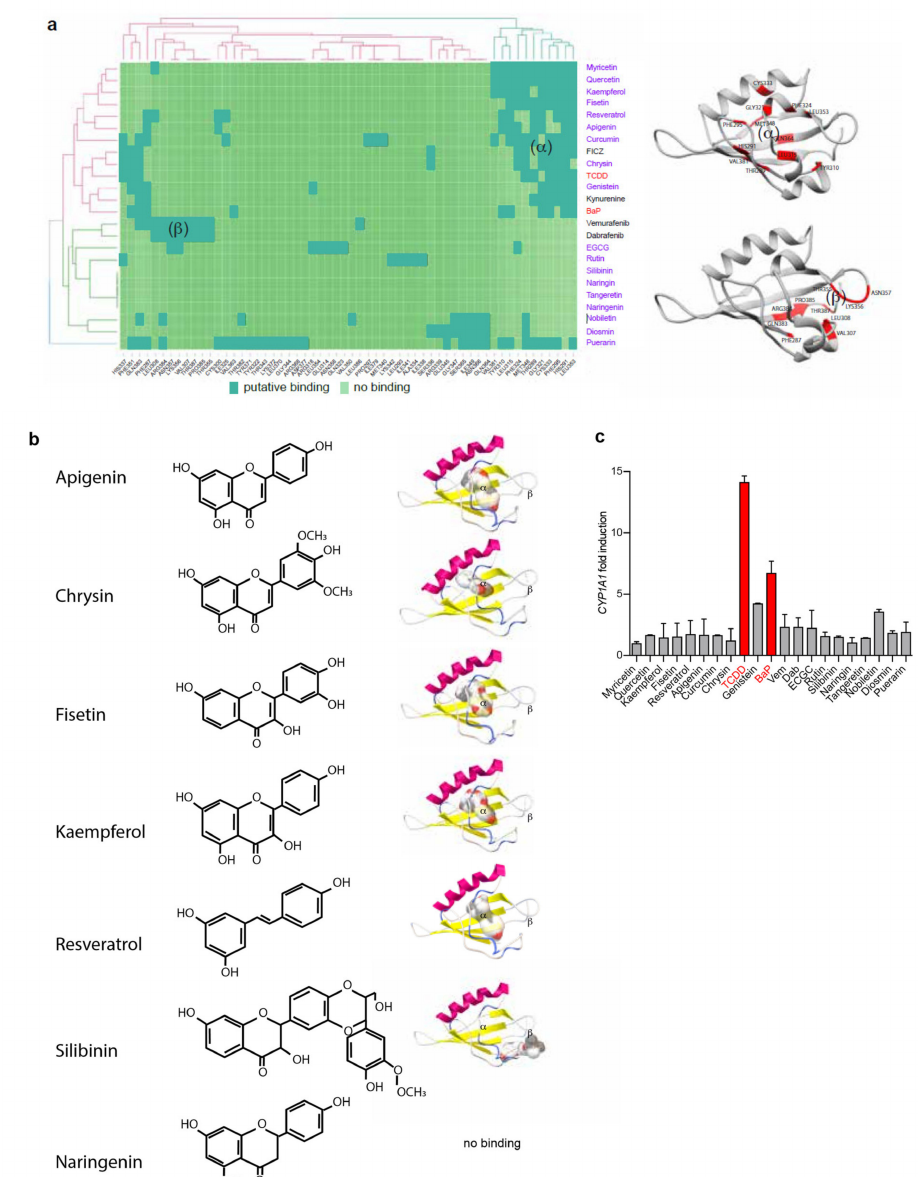
Figure 1. Flavonoids are potential AhR ligands. ( a ) Left: Heat map showing hierarchical clustering of AhR ligands or various flavonoids and their putative interactions with amino-acids of the PAS B domain of AhR. Several flavonoids cluster with canonical AhR ligands, such as TCDD, FICZ, BaP, and kynurenine, whereas BRAFis cluster together in a di ff erent position of the PAS B domain. Right: 3D representation of the PAS-B domain of AhR. Amino acids of the α (top) and β (bottom) binding pockets are highlighted in red. ( b ) Chemical structures and proposed binding mode of the natural flavonoids apigenin, chrysin, fisetin, kaempferol, resveratrol, and silibinin to AhR PAS-B ligand-binding domain homology model. The free binding energy is reported in Table S2. The two predictive ligand-binding pockets are indicated by ( α ) or ( β ) ( c ) CYP1A1 expression in 501Mel cells exposed to vehicle, flavonoids (1 µ M), BRAFi: vemurafenib (Vem) and dabrafenib (Dab) (1 µ M), or AhR ligands (TCDD) (10 nM) ( n = 2) for 48